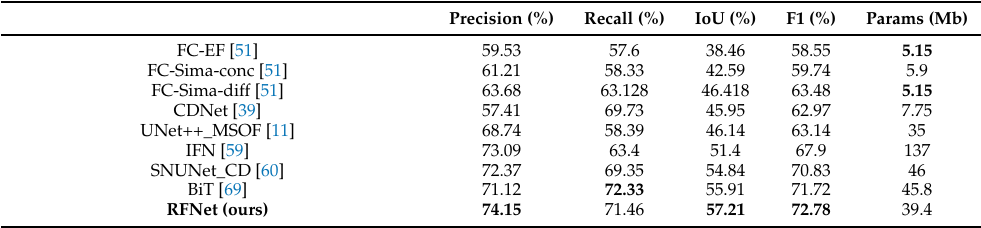
Table 4. Model comparison of the SECOND dataset. The values in bold font are the best.